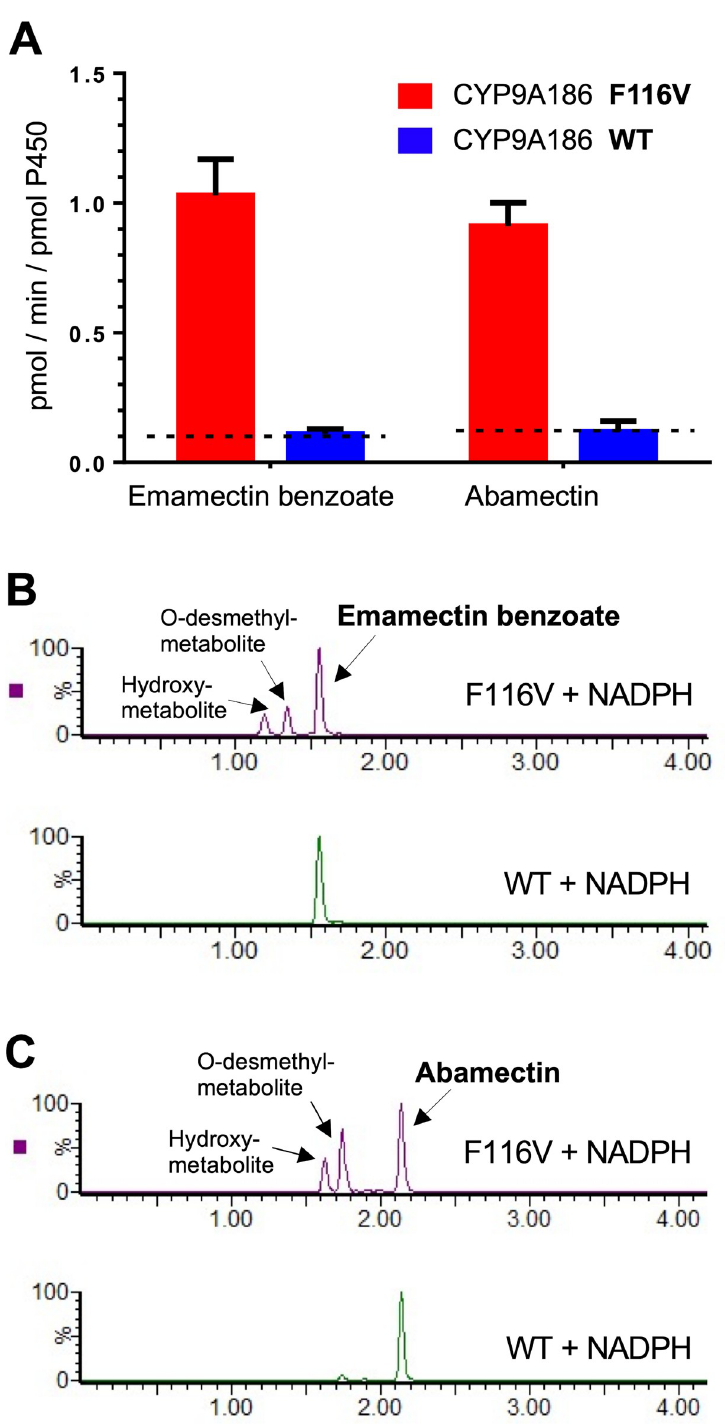
Fig 5. Metabolism of emamectin benzoate and abamectin by microsomes containing recombinant CYP9A186 and CYP9A186-F116V. ( A ) Specific activity (pmol/min/pmol P450) of EB and abamectin hydrolysis. Data are mean values ± SEM (n = 6). Dotted lines show mean limits of detection (LOD). There is no significant difference between WT and LOD (One sample t -test, p = 0.69 and 0.83 for emamectin benzoate and abamectin, respectively). ( B ) MRM signals of emamectin benzoate and its metabolites. ( C ) MRM signals of abamectin and its metabolites.